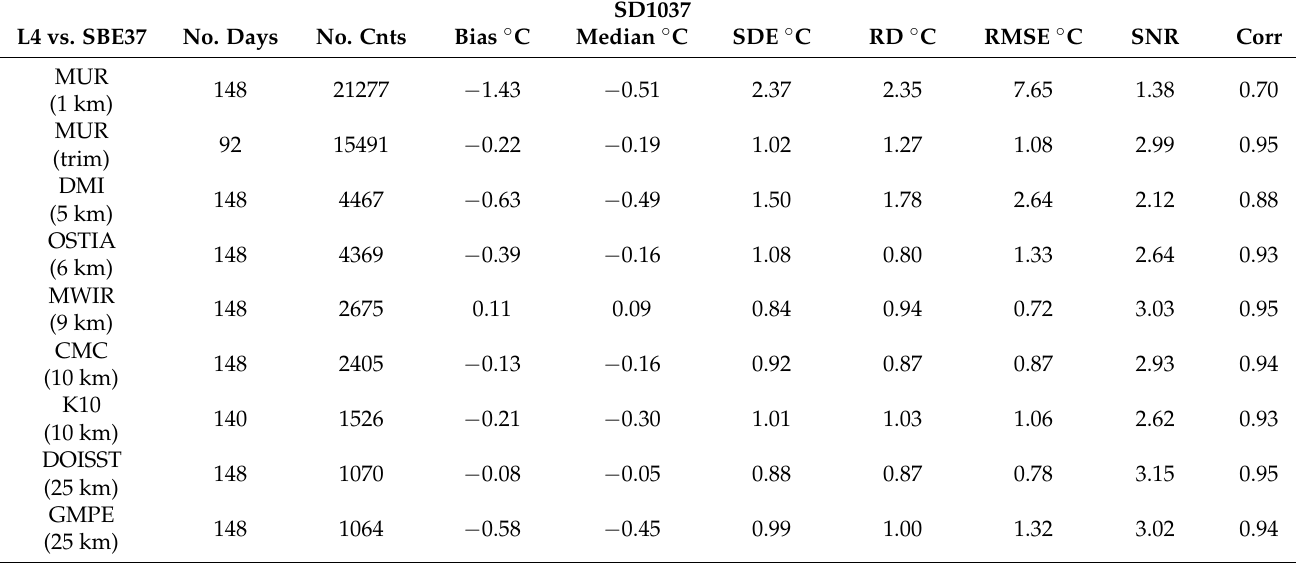
Table 3. Statistics for GHRSST L4 vs. saildrone SBE37 on SD1037 deployment.